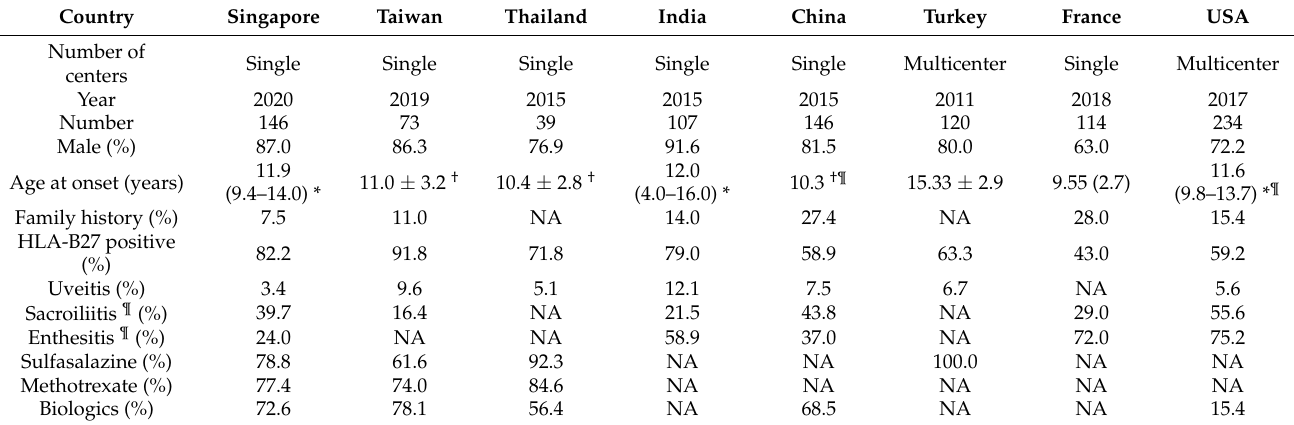
Table 4. Comparative data on enthesitis-related arthritis (ERA) characteristics across